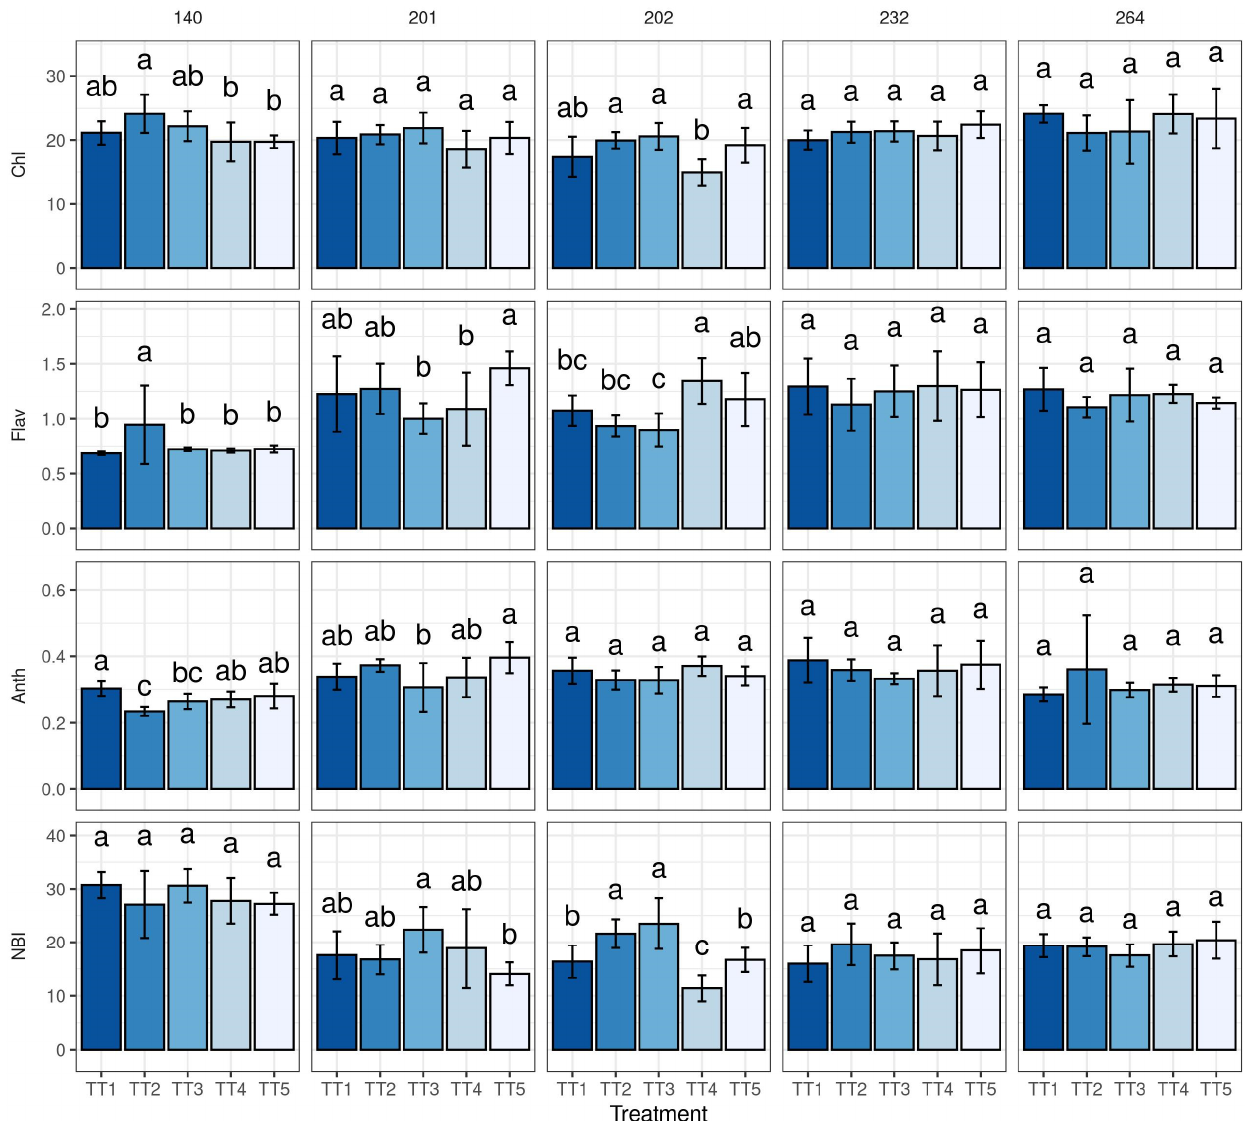
Figure 3. Barplot of raspberry Himbo Top mean chlorophyll (CHL), flavonoids (FLA) and anthocyanins (ANTH) index, and nitrogen balance index (NBI) depending on DOY and depending on the substrate. TT1 = Commercial Peat (P) 90% + Compost A(CA) 10%; TT2 = P 80% + CA 20%; TT3 = P 60% + CA 40%; TT4 = Commercial Peat (P) 100%; TT5 = P Commercial Peat 100% + Osmocote. Error bars indicate standard deviations around the mean. Different letters indicate statistically significant di ff erences after ANOVA and Duncan post-hoc test at p -value < 0.05.